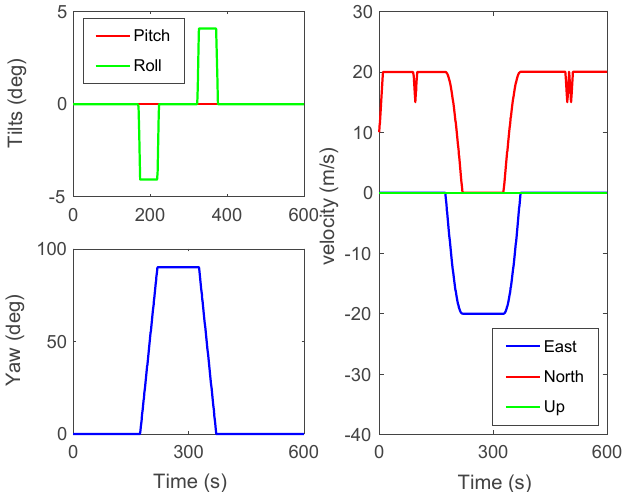
Figure 2. The in-motion status of the vehicle.